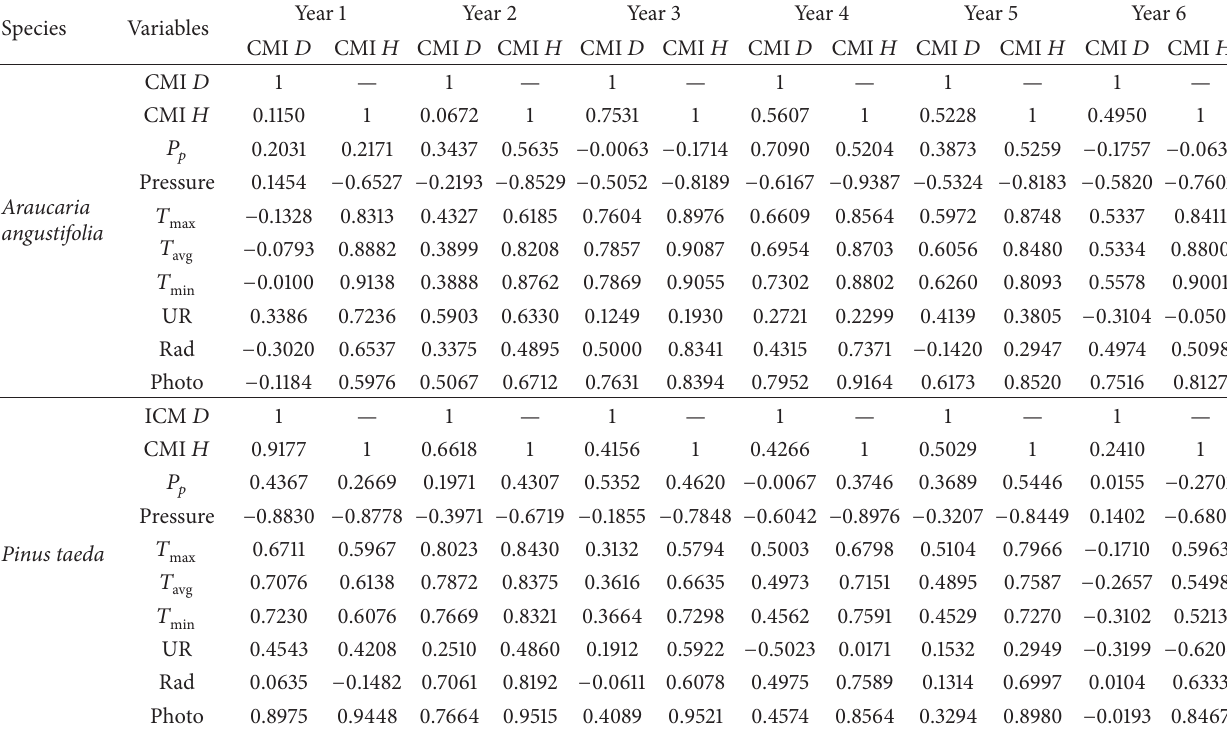
Table 1: Correlation matrix between the current monthly increment in diameter and height of the species Araucaria angustifolia and Pinus taeda over the six-year evaluation period with climatic